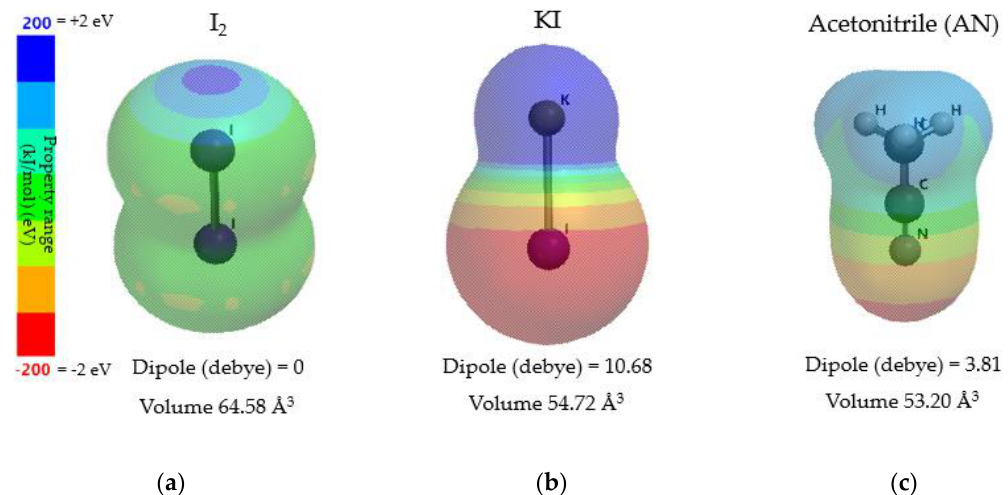
Figure 1. Electrostatic potential map with dipole as a measure of solubility: ( a ) I 2 ; ( b ) KI; ( c ) acetonitrile